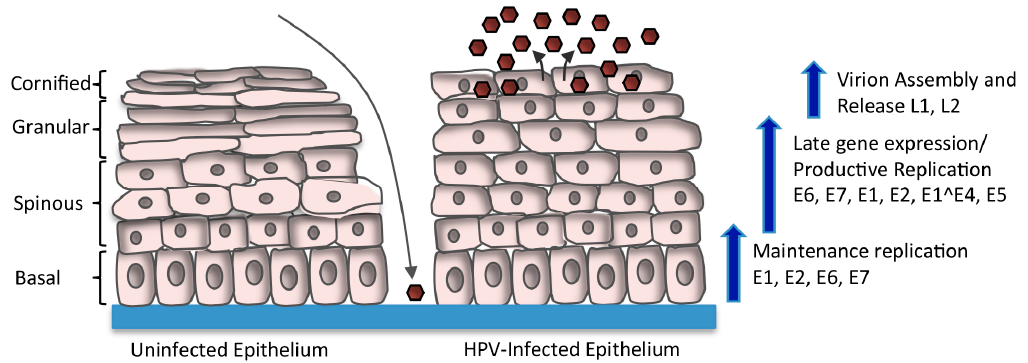
Figure 1. Human papillomavirus (HPV) Life Cycle. HPV infects the basal layer of the stratified epithelium through a microwound. Upon entry into the cell, the virus transiently amplifies to 50–100 copies per cell. HPV genomes are maintained at a stable copy number in undifferentiated basal cells by replicating along with cellular DNA. Upon differentiation, the productive phase of the life cycle is activated, resulting in late gene expression and amplification of viral genomes to thousands of copies per cell. The expression of E6 and E7 allows for cell cycle re-entry upon differentiation, providing cellular factors for productive replication. E4 and E5 also contribute to efficient productive replication. Expression of L1 and L2 promotes the encapsidation of newly replicated genomes, resulting in virion release from the uppermost layers of the epithelium (brown hexagons).